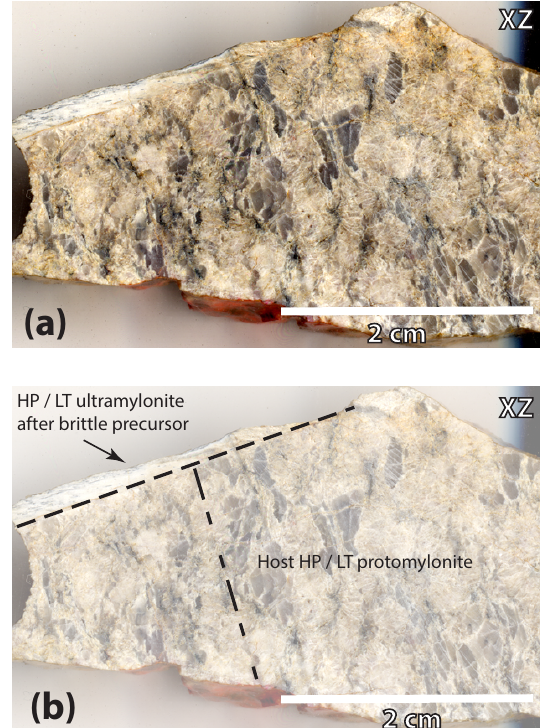
Figure 2. The analysed sample of a protomylonitic metagranite with millimetre-scale ultramylonite (compare a and b ). The dashed lines in (b) are the trace of foliation in the protomylonitic host and the sharp shear zone boundary of the ultramylonite developed after a brittle precursor. All observable deformation structures were devel- oped under high-pressure, low-temperature (HP/LT) metamorphic